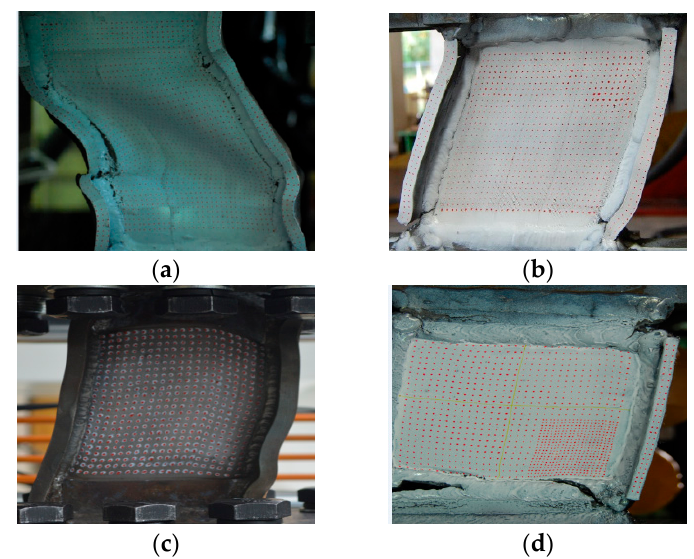
Figure 10. Failure modes of dampers: ( a ) SPD100-50; ( b ) SPD100-10; ( c ) SPD160-28; and ( d ) SPD100-rib.